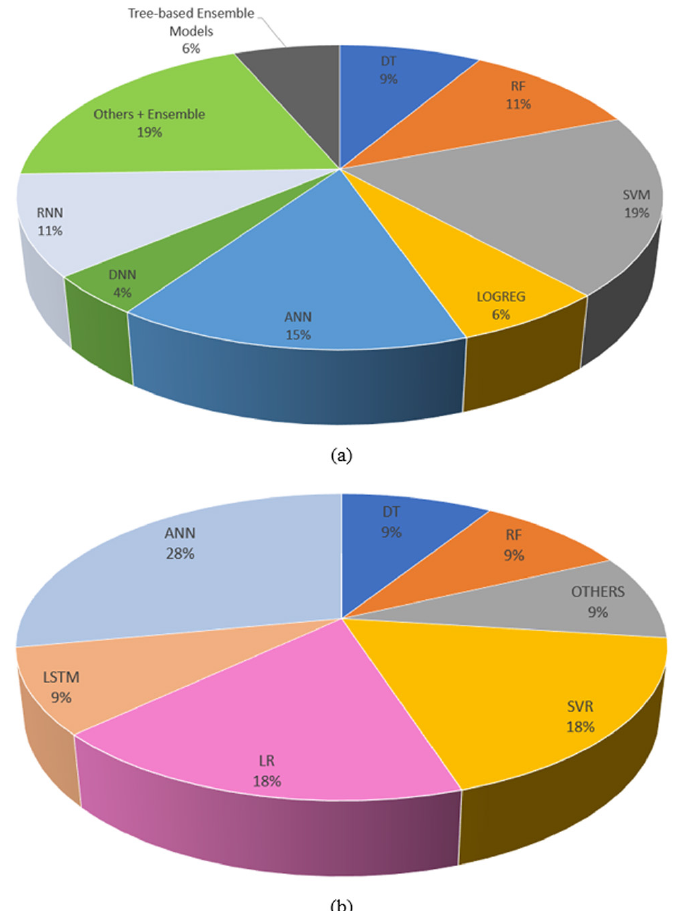
Figure 5. The use of machine learning models in student performance prediction studies: ( a ) classifi- cation and ( b )